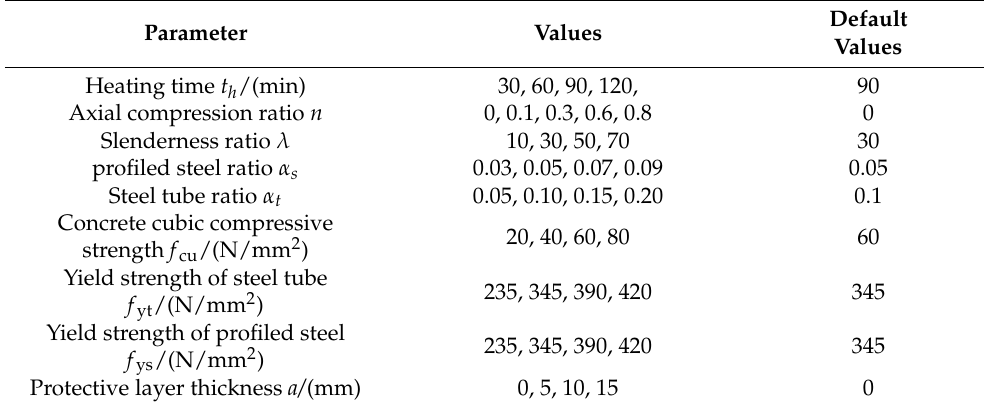
Table 5. Summary of specimen dimensions of the post-fire seismic